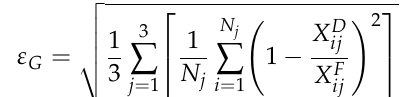
d versus ( a ) Re , ( b ) δ and ( c ) λ .